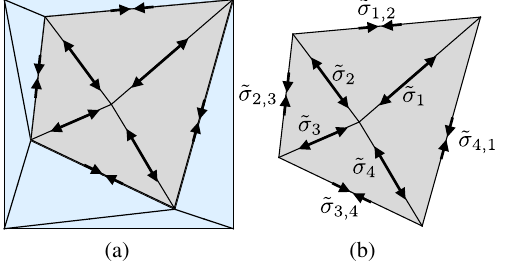
FIG. 3. (a) Extracting a single internal vertex from a larger origami structure. (b) The “ wheel stress ” for each single vertex, represented as either extensional or compressional arrows, is also present as a self-stress in the larger origami structure of (a). Indeed, such wheel stresses form a basis for the space of self- stresses of a generic unfolded triangulated origami; thus, the dimensionality of that space is equal to the number of internal vertices. The labels in (b) are associated with Eq.